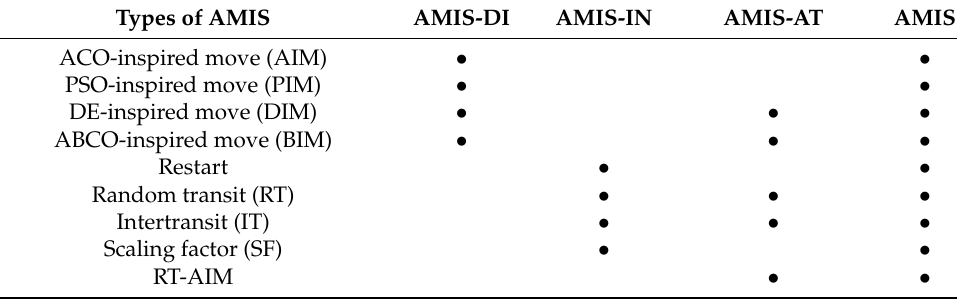
Table 19. Details of the AMIS subalgorithms.